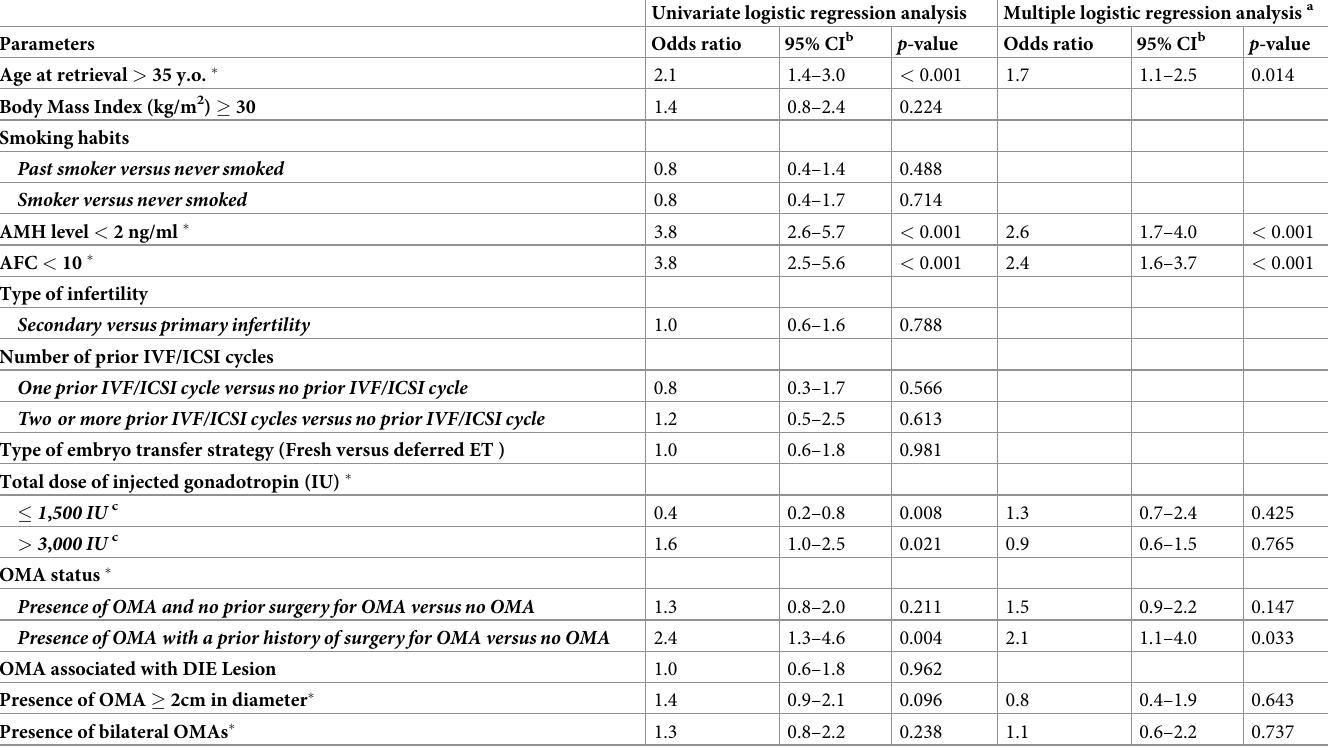
Table 3. Logistic regression analysis of the risk factors for a poor response to hyperstimulation #